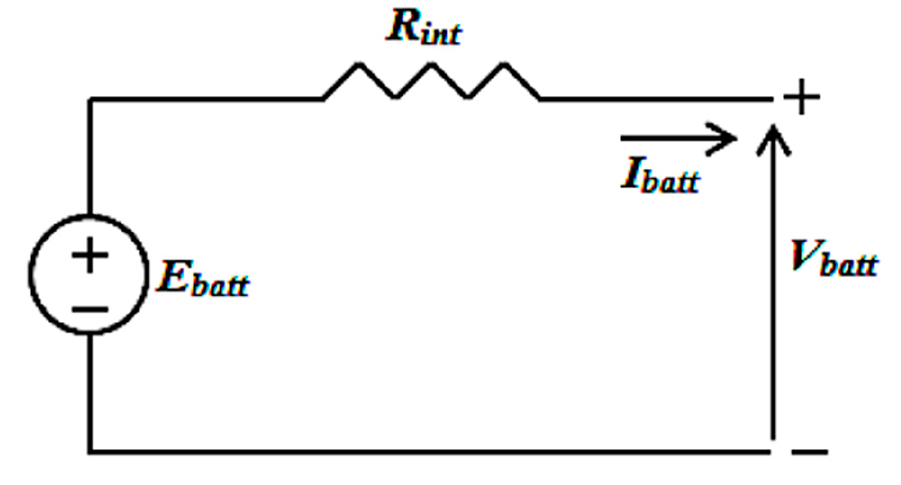
Figure 3. Battery equivalent circuit. Table 2. Li-ion battery parameters.